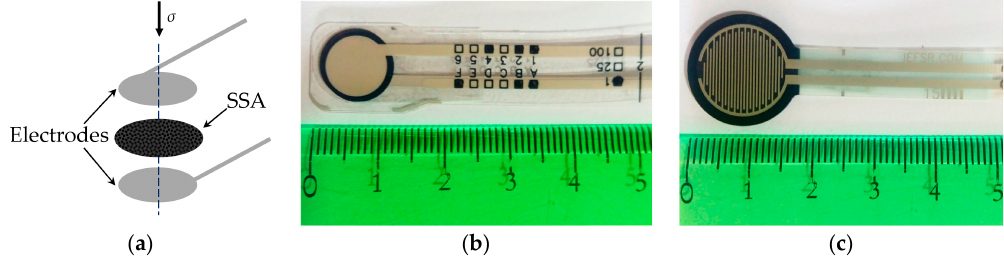
Figure 1. Schematic and pictures of commercial Force Sensing Resistors (FSRs). ( a ) Sketch of an FSR assembled under the Traditional Sandwich Element (TSE). The direction of normal stress ( σ ) is signaled with an arrow; ( b ) Picture of a FlexiForce A201-1 sensor; ( c ) Picture of an Interlink FSR 402 sensor. A centimeter ruler has been added for scaling purposes.